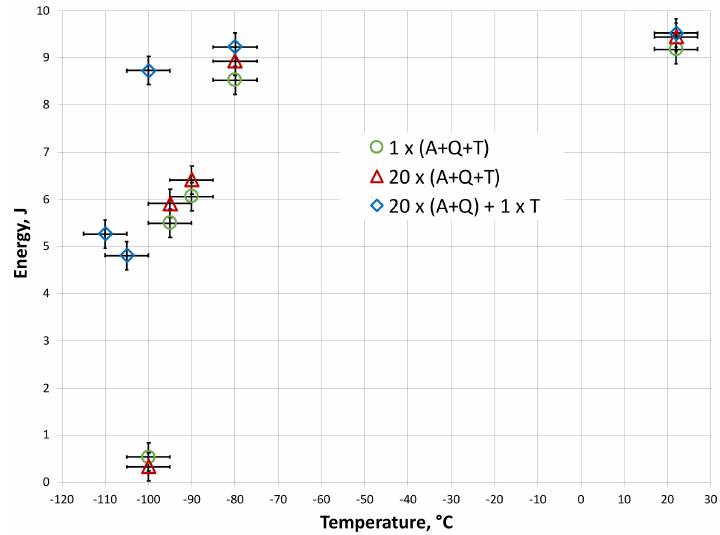
Figure 7. The effect of multiple heat treatments on the Charpy impact energy (KLST) of EURO- FER97/2 (25 mm plate, heat 993402). The reference samples (circles) were austenitized at 980 ◦ C for 30 min (A), air quenched (Q), tempered at 750 ◦ C for 2 h (T), and finally air cooled. For comparison, another set of samples was 20 times heat treated the same way, i.e., 20 × (A + Q + T). Finally, another set was prepared by 20 times repeating only austenitization and quenching, i.e., 20 × (A + Q), which was then followed by one tempering treatment (1 × T). The instrumented Charpy tests were performed according to the EU standard for small size specimens (KLST type). The specimens were oriented in L-S direction.